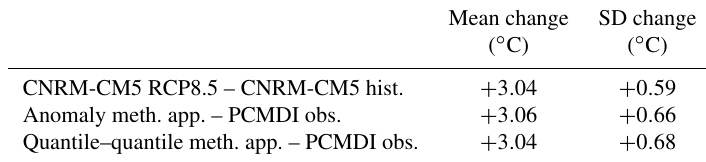
Table 1. Mean and standard deviation change between present and future SST data sets for the North Atlantic (45 to 58 ◦ N, 105 to 85 ◦ W).